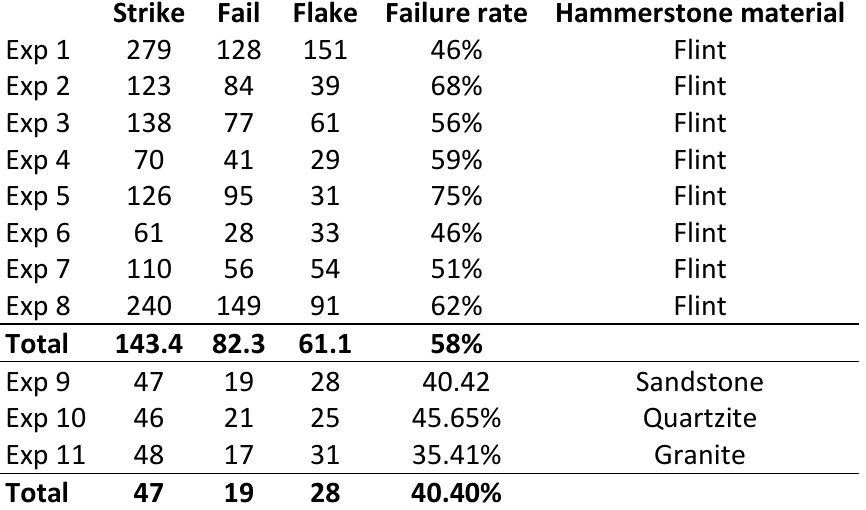
Table 1. Relationship between flake success and failure using flint hammerstone and other raw materials.